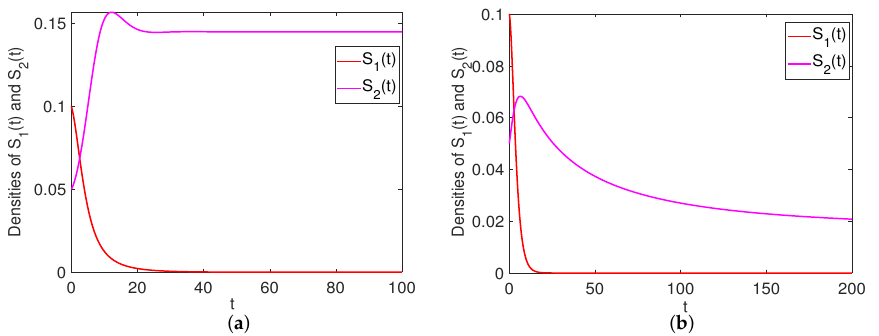
Figure 11. The dynamics of S 1 ( t ) and S 2 ( t ) . ( a ) (cid:60) 01 = 0.95 < 1 and (cid:60) 02 = 1.5. ( b ) (cid:60) 01 = 0.28 < 1 and (cid:60) 02 = 1.